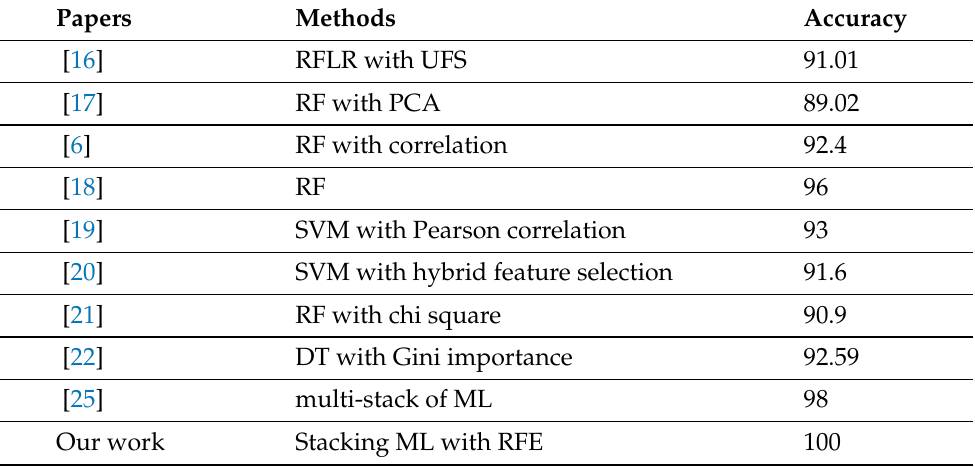
Table 4. Comparison with previous